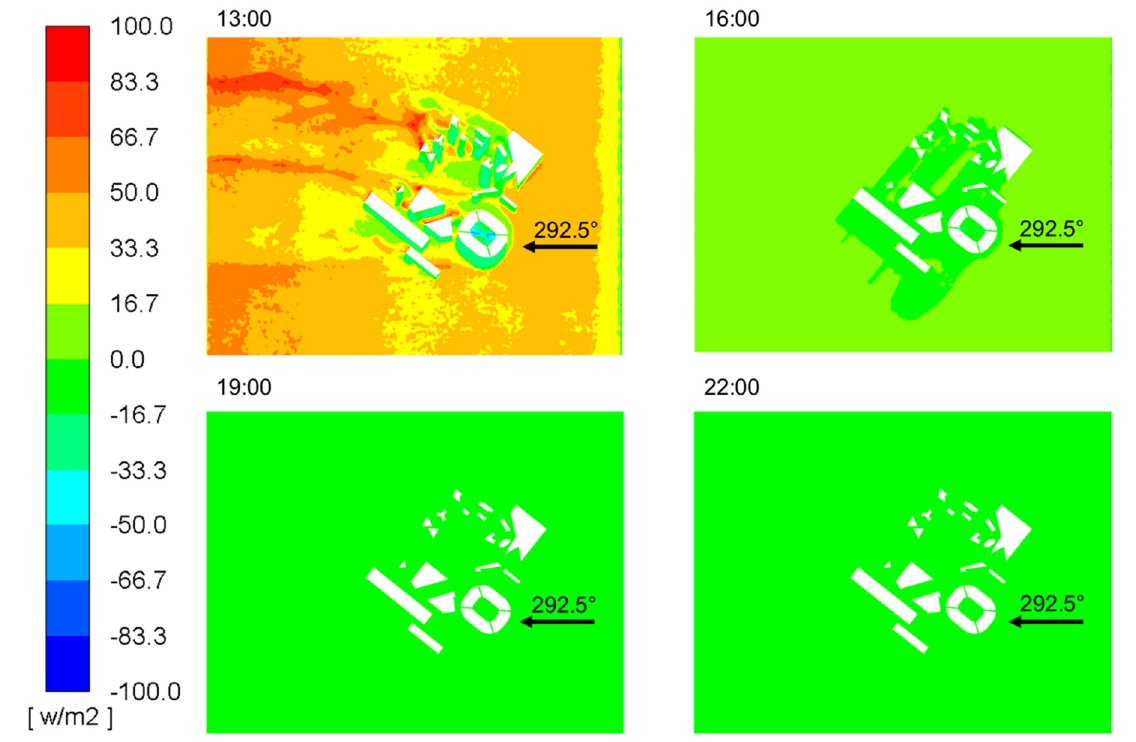
Figure 9. Radiation heat flux contours on the ground for the match kick-off times on the event opening day for the 2022 World Cup. Table 6. Radiation heat fluxes for the ground, stadium, and surrounding buildings at kick-off times on the opening day of the event.